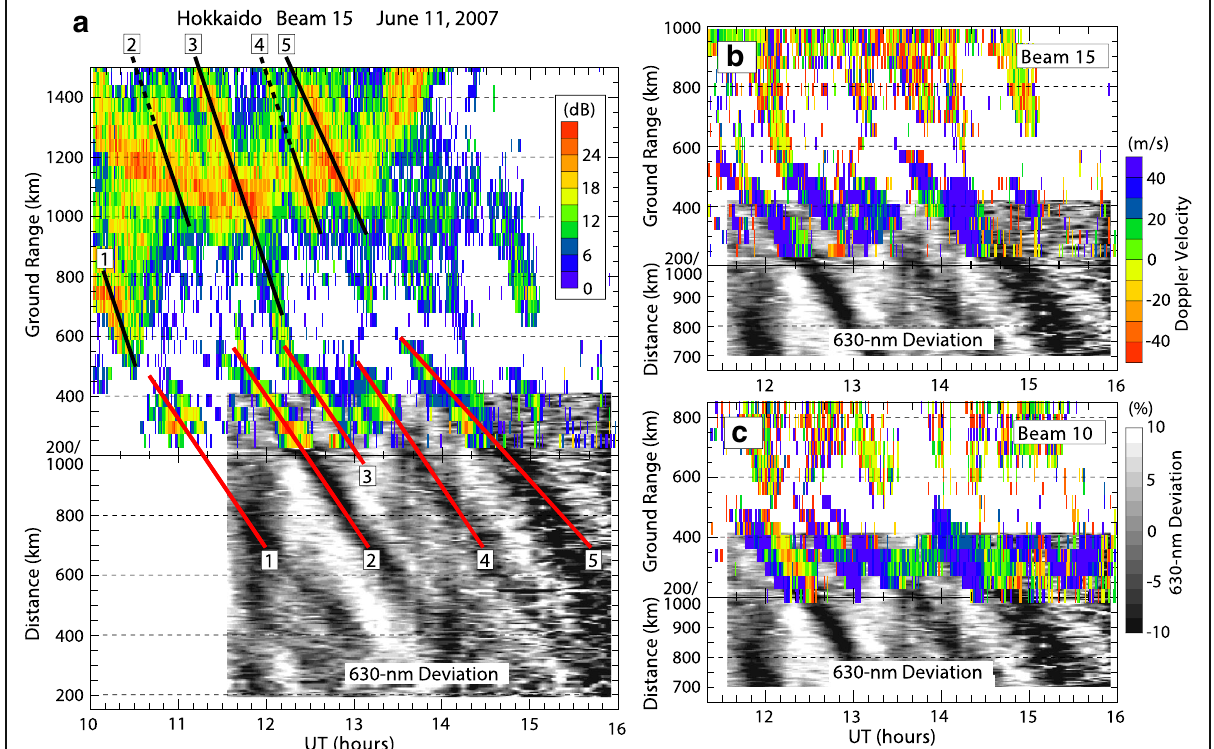
Fig. 20 Keograms from the Hokkaido radar of a radar echo power on beam 15 and airglow intensity deviation and b Doppler velocity and c airglow intensity deviation on beam 15 and 10 on 11 June 2007. Trace velocities indicated by red lines with numbers 1 – 4 and number 5 are 120 and 90 m s − 1 , respectively, and those indicated by black lines with numbers 1 – 4 and number 5 are 240 and 180 m s − 1 , respectively. Reproduced from Fig. 12 of Ogawa et al.